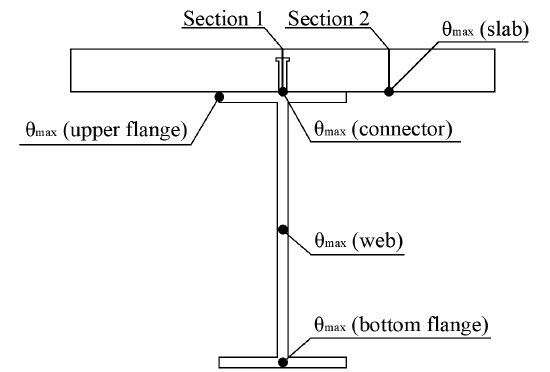
Figure 8. Maximum temperature regions of the composite cross-section